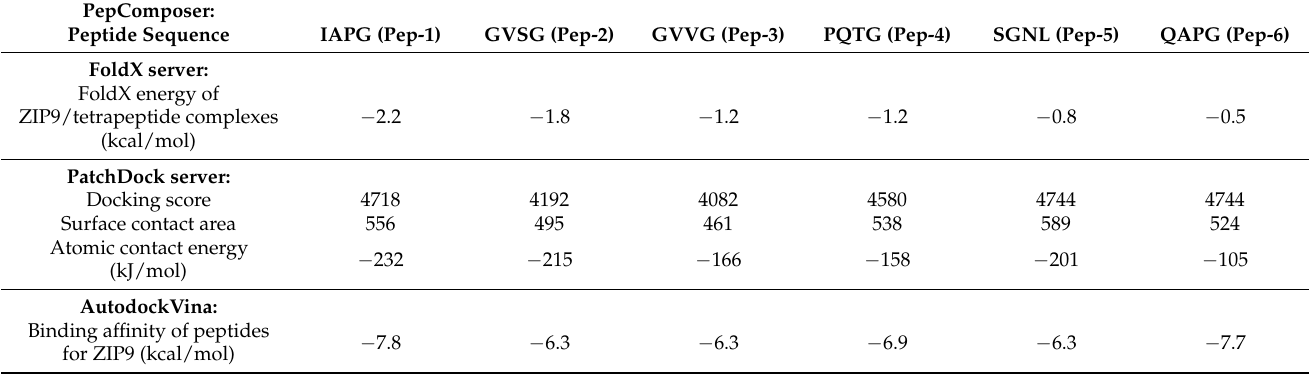
Table 2. Identification of ZIP9-directed tetrapeptides and their properties. The programs and servers used for the identification of the peptides and their interactions with the androgen binding site of ZIP9 are presented in white letters.